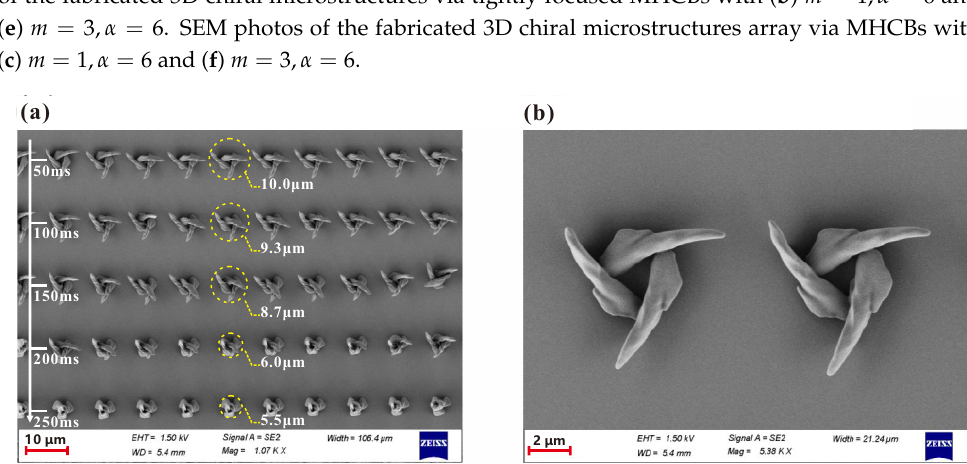
Figure 7. SEM photos of the fabricated 3D chiral microstructures under different exposure times. ( a ) The exposure time increases with a step of 50 ms along the white arrow. ( b ) Two Chiral microstruc- tures were fabricated under an exposure time of 50